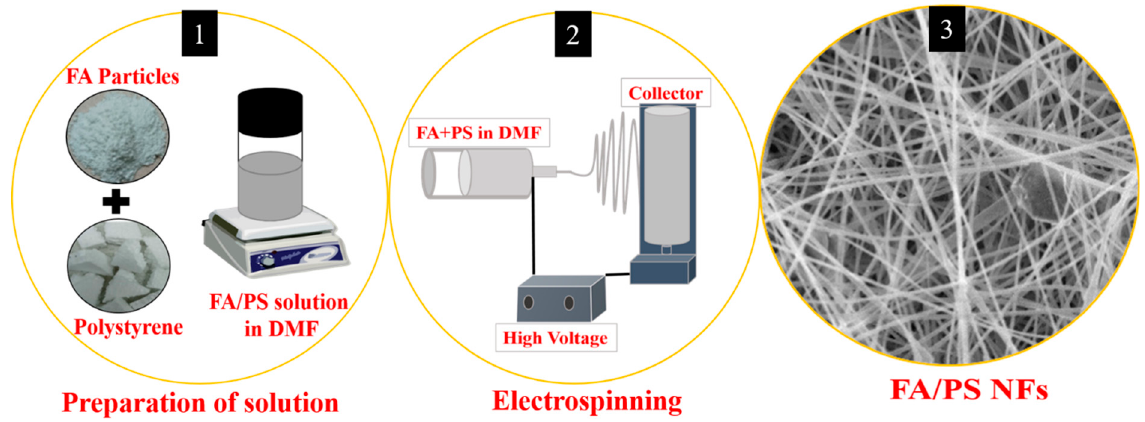
Figure 1. Schematic diagram showing the fabrication of the FA/PS fiber composite.